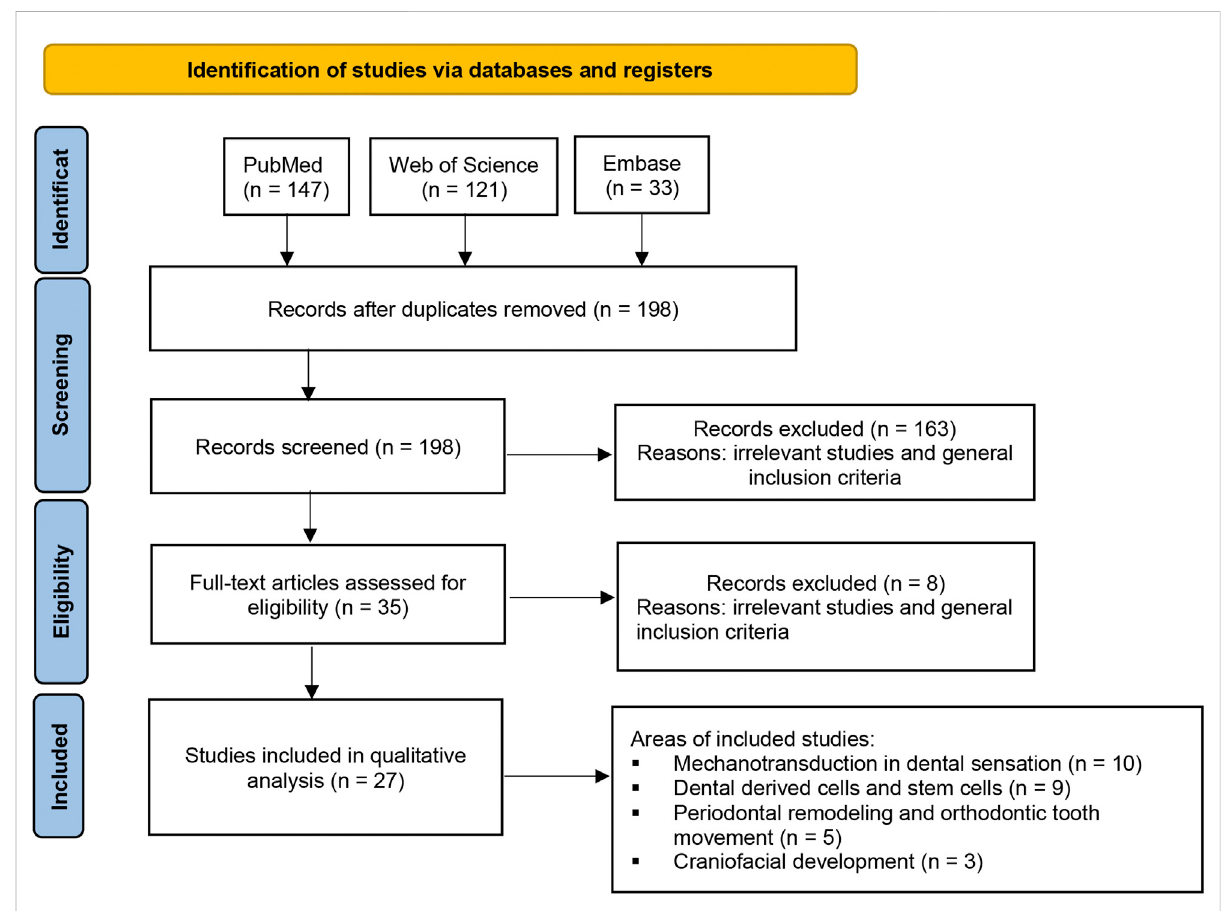
Flow diagram of the study selection process. A total of 301 studies were retrieved based on the search strategy. After removing the duplicates and reviewing the titles and abstracts, 35 records were obtained. After reviewing the full text of these 35 articles, 27 studies met the inclusion criteria and were included in this